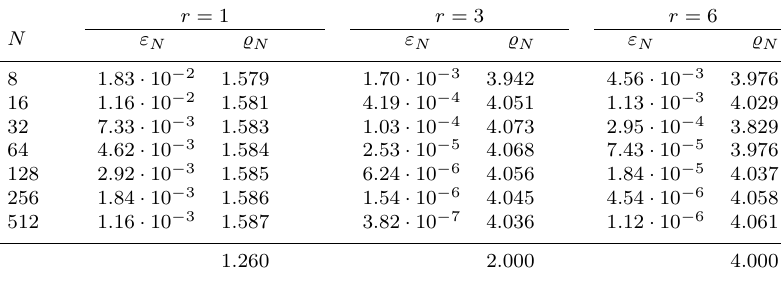
Table 2. Numerical results for problem (6.1)–(6.2) using Method 1, with Gauss collocation points (6.4) and m = 2.